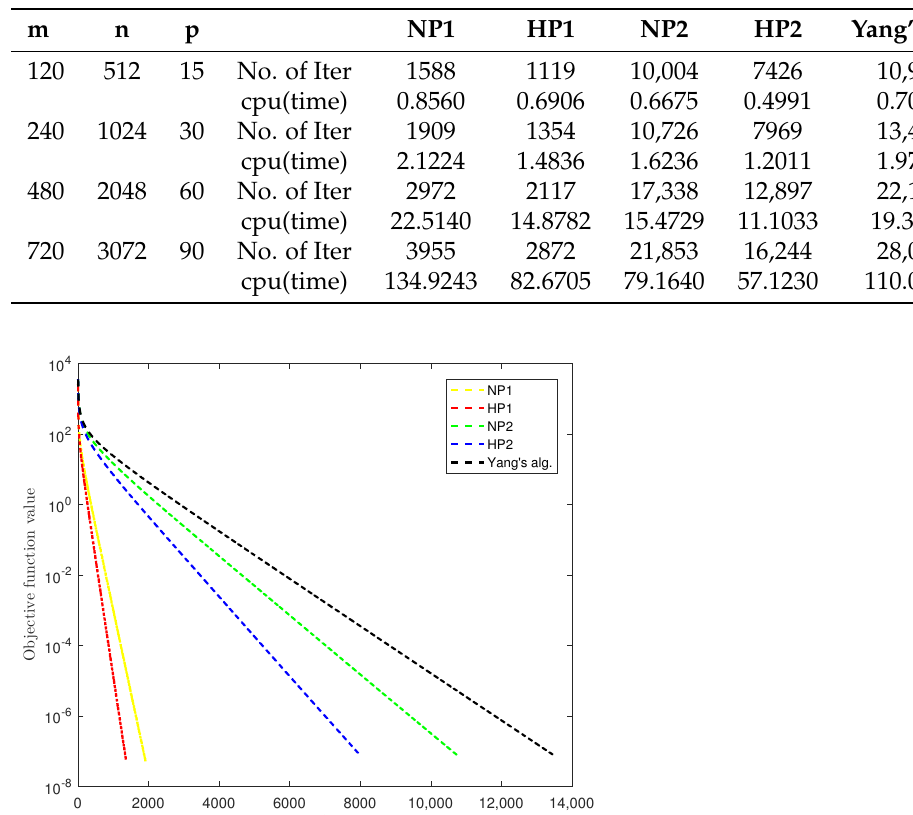
Table 1. Comparison of algorithms with different step size.